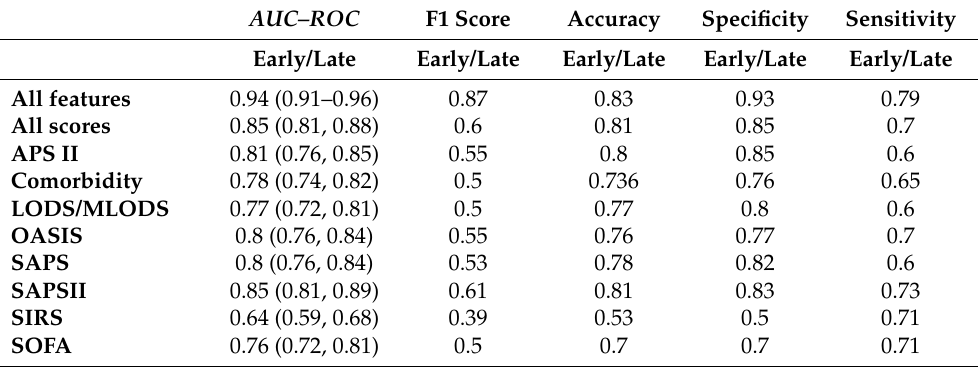
Table A3. Analytical metrics of performance of predictive models for early mortality in patients with thrombosis from MIMIC-III database (Abbreviations: APS, Acute Physiology Score; LODS, Logistic Organ Dysfunction Score; OASIS, Outcome and Assessment Information Set; SAPS, Simpli- fied Acute Physiology Score; SIRS, Systemic Inflammatory Response Syndrome; SOFA, Sequential Organ Failure).